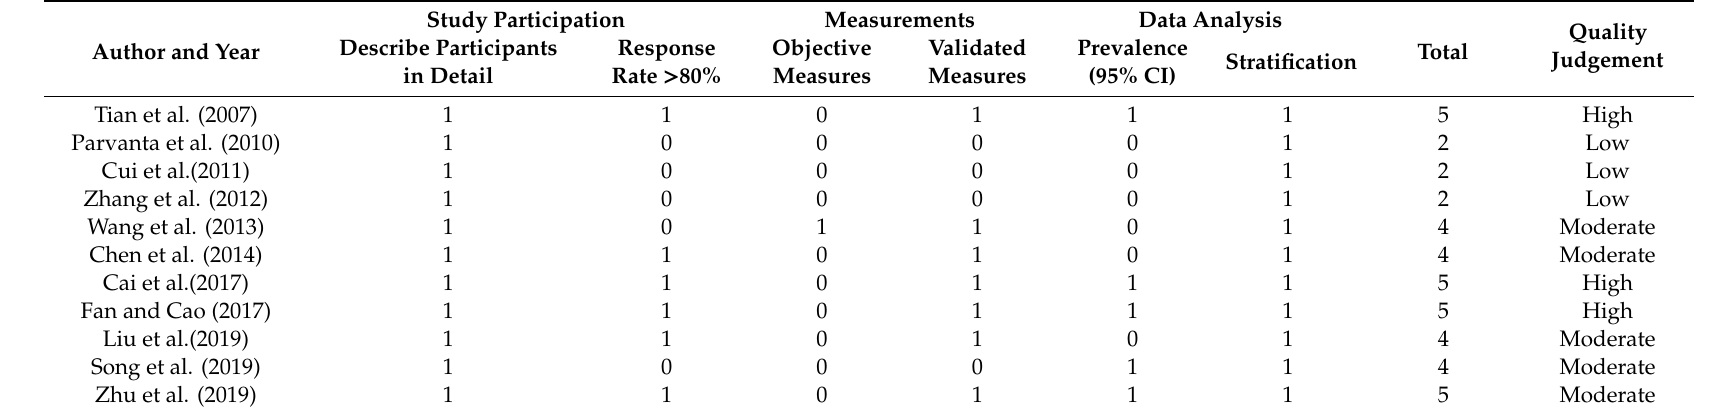
Table 3. Quality assessment of each study included in this